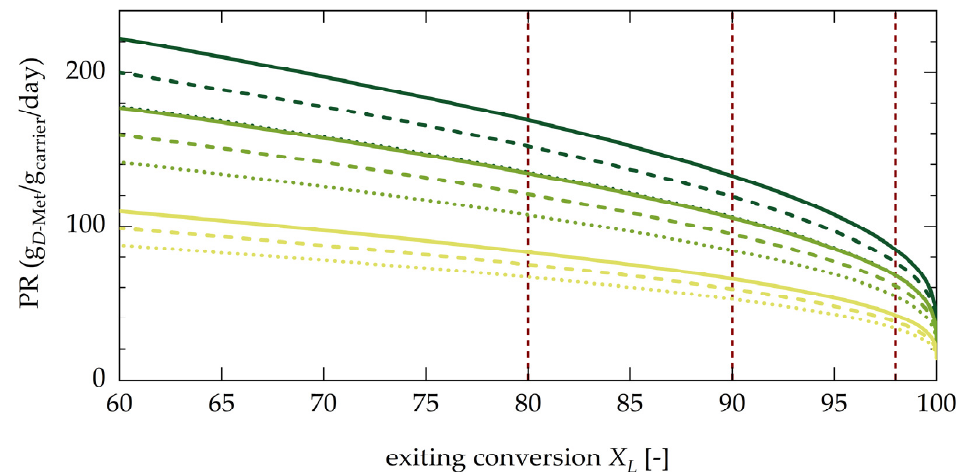
Figure 9. Productivity PR D-Met of racemization reaction with the AAR for different total concentra- tions c tot : 30 g/L (dark green), 20 g/L (medium green), and 10 g/L (light green)), and varying initial (entering) enantiomeric excess at the EFBR inlet ee L, 0 (100% ( − ), 90% (- -), 80% ( ∙∙∙ )) as a function of the conversion exiting the reactor X L,target .